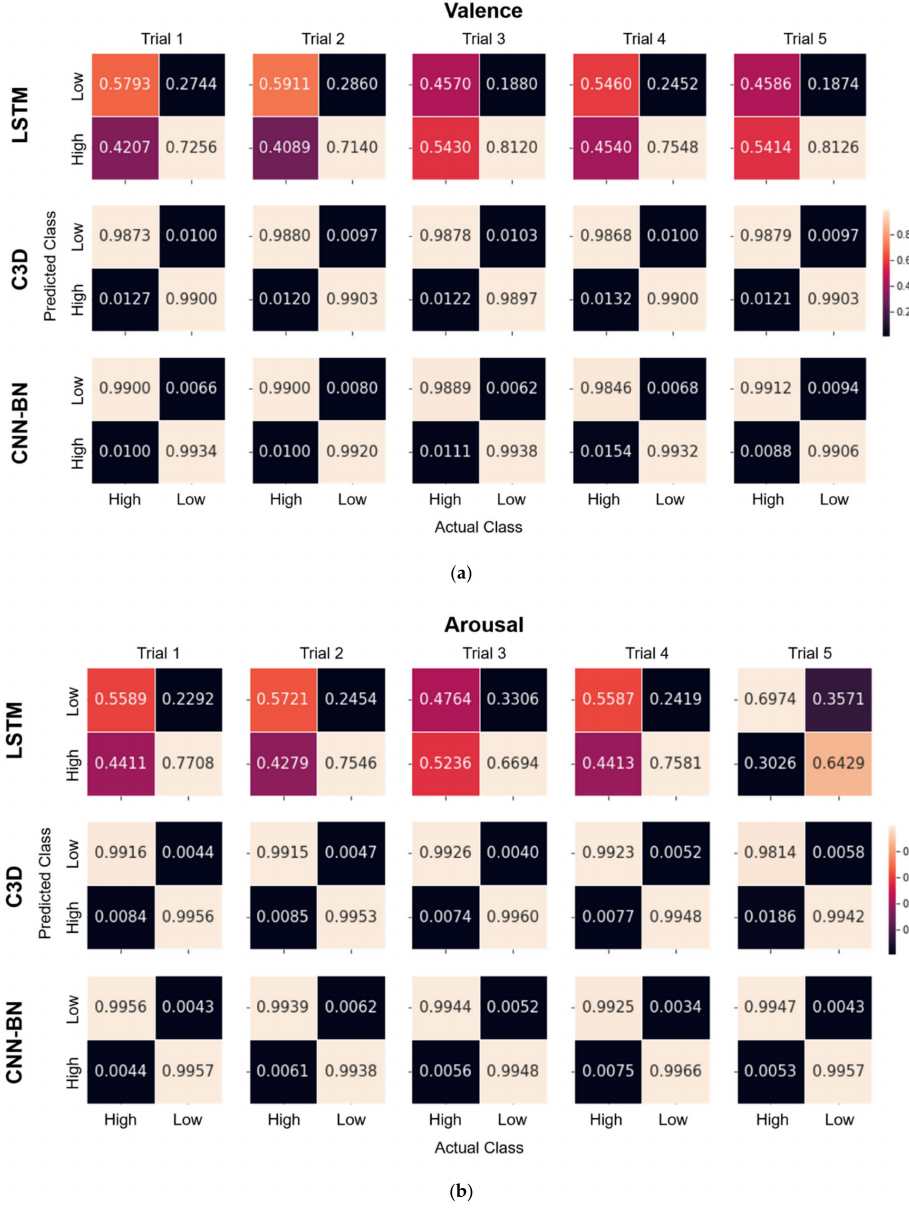
Figure 6. Confusion matrices of the binary emotion classification for ( a ) valence and ( b ) arousal for every trial (5 trials) for the LSTM model (top) and C3D model (middle) considered as baselines and the proposed CNN-BN model